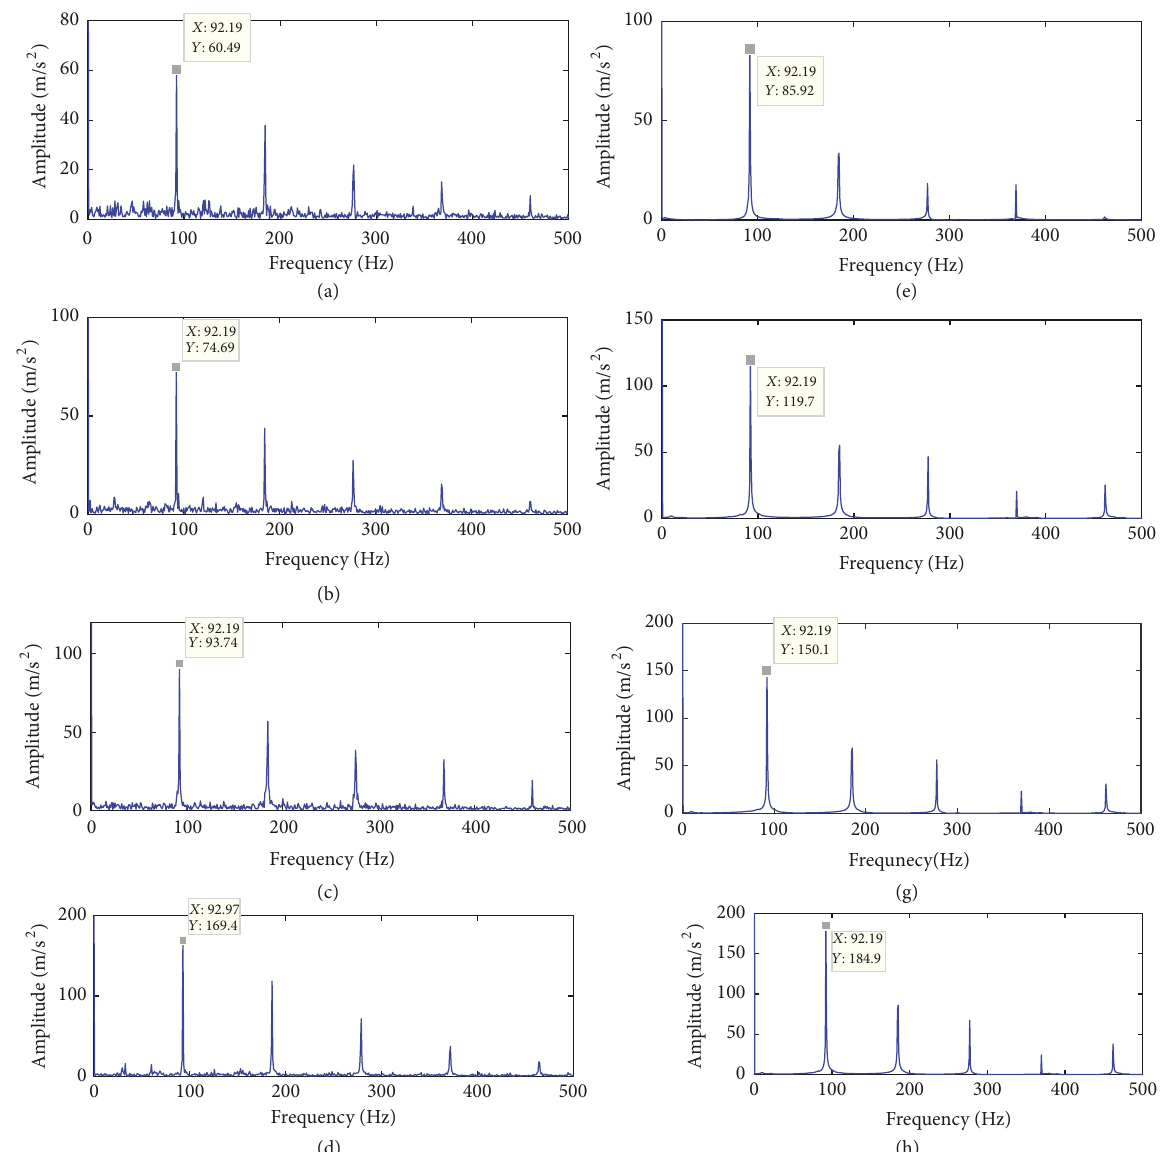
Figure 11: Frequency spectra of the experimental signals and the numerical signals under different loads. Experimental signals: (a) 4.9 N, (b) 9.8 N, (c) 14.7N, and (d) 19.6 N. Numerical signals: (e) 4.9 N, (f) 9.8 N, (g) 14.7 N, and (h) 19.6